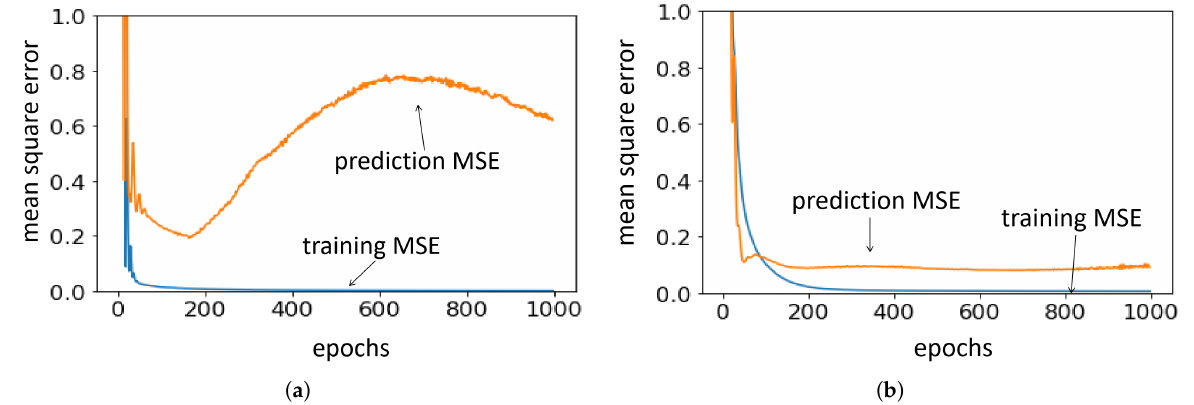
Figure 5. Error curves of the random ( a ) and the proposed sampling method ( b ).